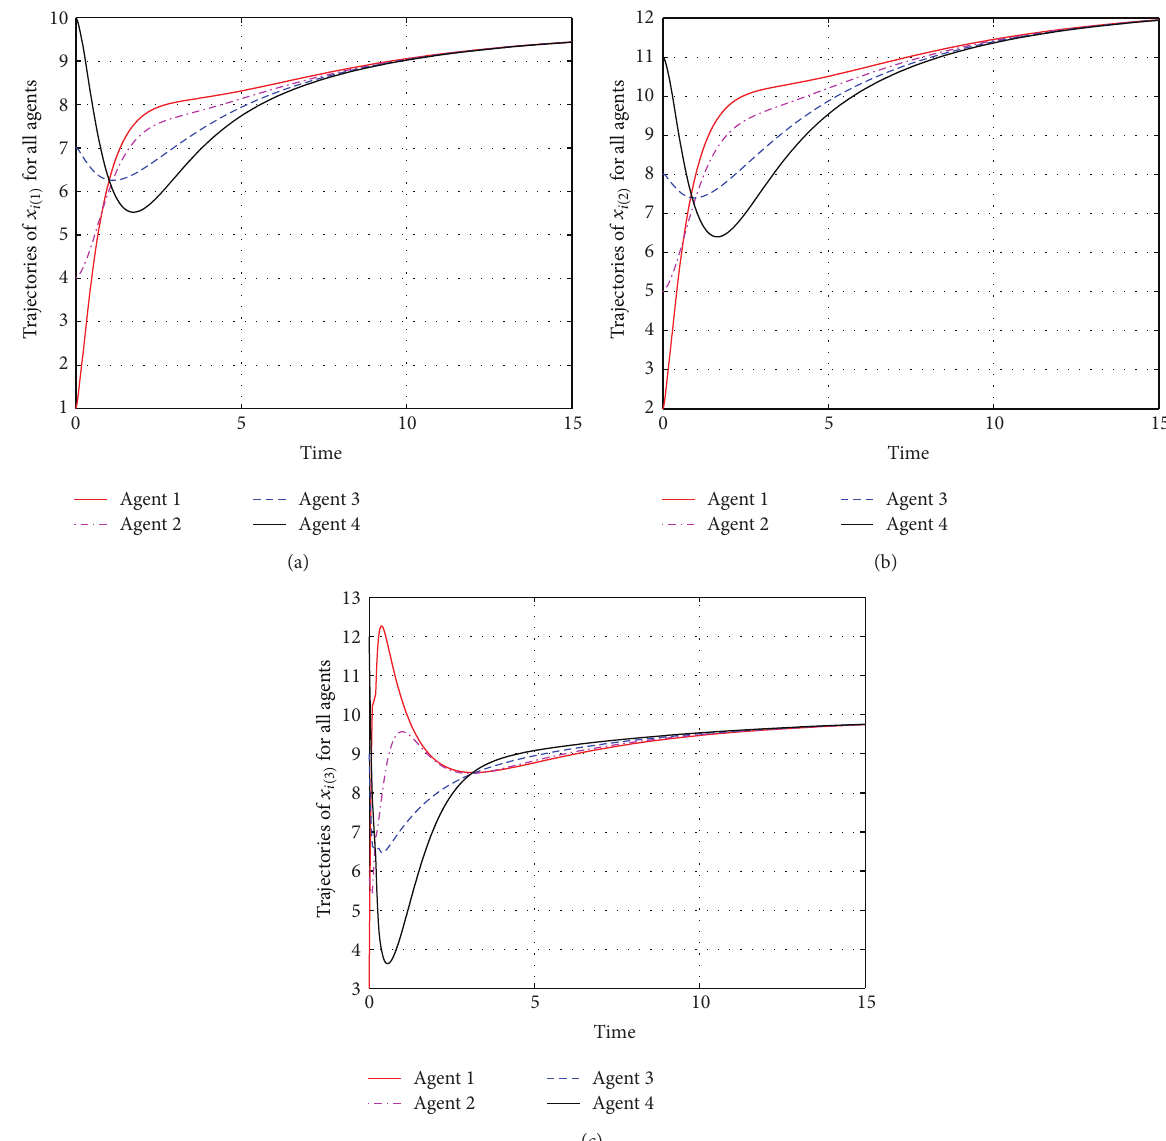
Figure 2: Trajectories 𝑥 𝑖(𝑗) (𝑡) ( 𝑗 = 1, 2, 3 ) of four